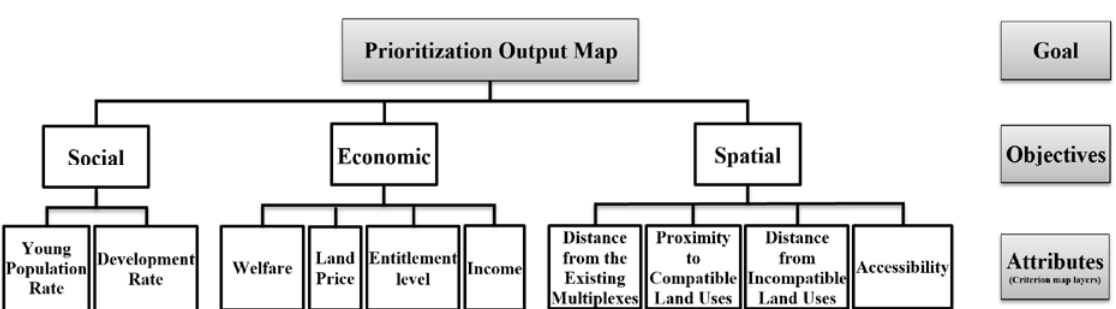
Fig. 2: Hierarchical structure of a 3-level decision problem for prioritizing 22 districts of Tehran for construction of multiplex buildings